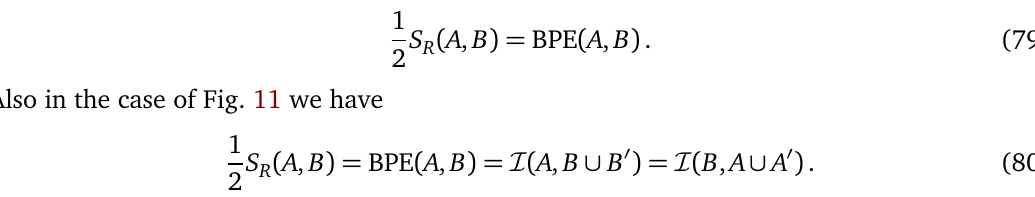
∪ B (cid:48) ∪ B (cid:48) and A (cid:48) 1 1 2 2